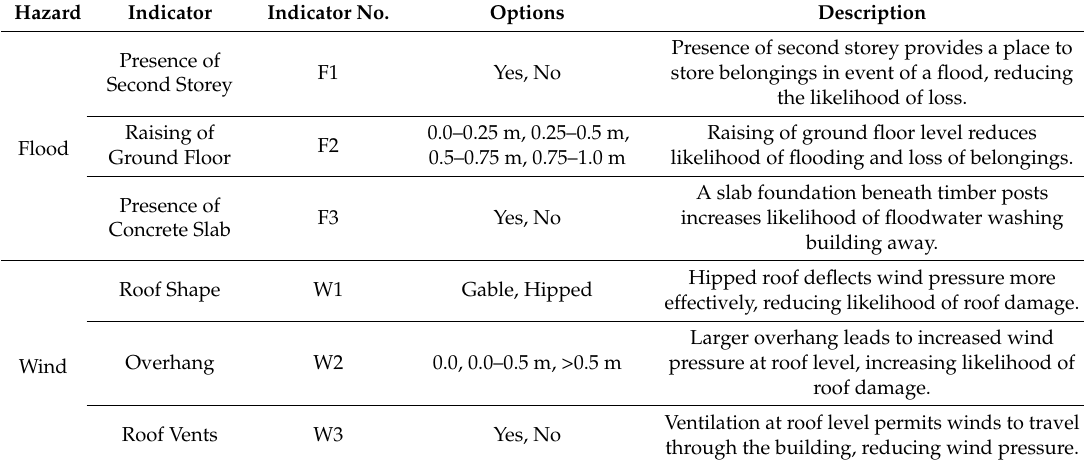
Figure 10. Schematic of vulnerability indicators showing mechanical processes in relation to flood and wind hazards and traditional rural Philippine building features. Vulnerability factors (VF) are given for different options relating to each indicator. Table 2. Description of vulnerability indicators for flood and wind hazard.